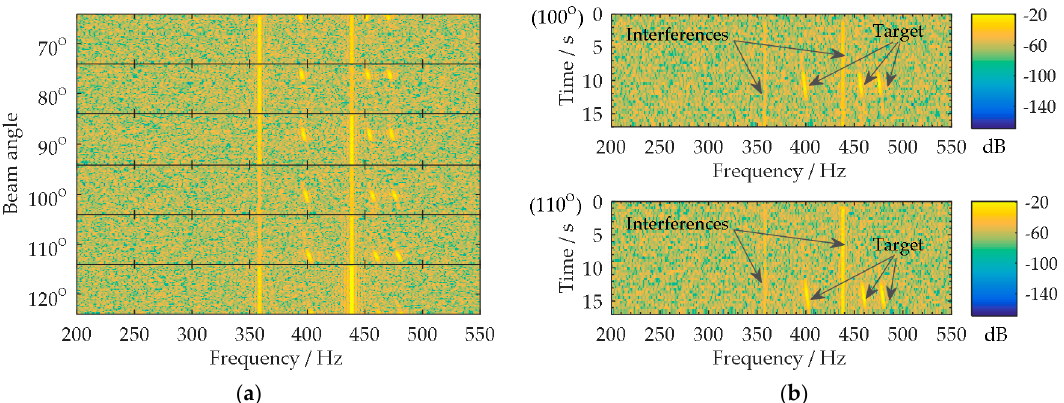
Figure 9. Multi ‐ beam lofargram analysis: ( a ) Multi ‐ beam lofargram; ( b ) The lofargrams in ( a ) corresponding to the beam angles of 100° and 110°.